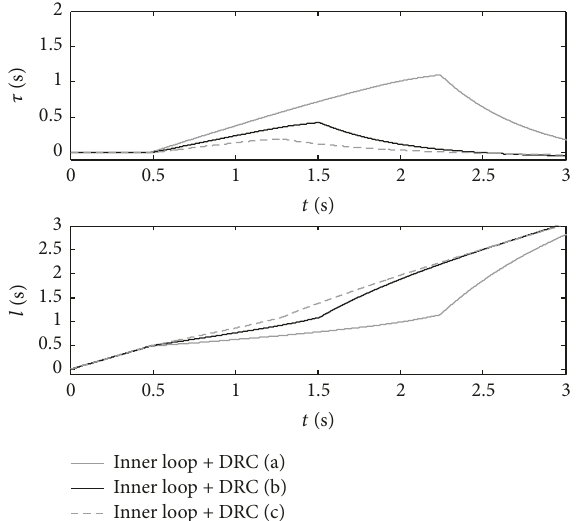
Figure 5: Time delay and action reference parameter versus time.